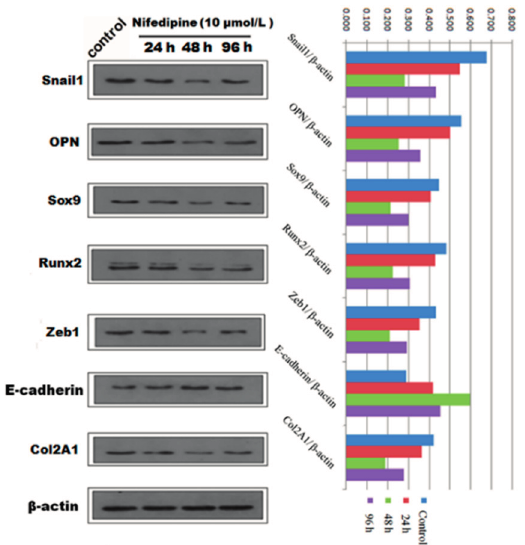
Figure 7. Qualitative and quantitative analysis of Western blot showed the protein expression of EMT and osteochondral-associated markers changed in a time dependent-manner with stimulation by 10 μ mol/L nifedipine in